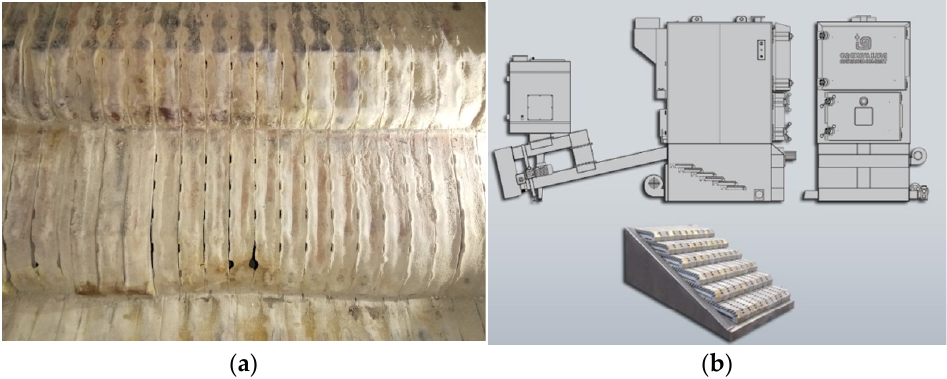
Figure 1. ( a ) Grate of the straw pellet furnace after one year, ( b ) schematic of the straw pellet